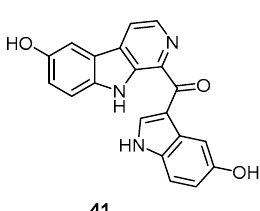
Figure 11. Chemical structure of hyrtiosulawesine ( 41 ).